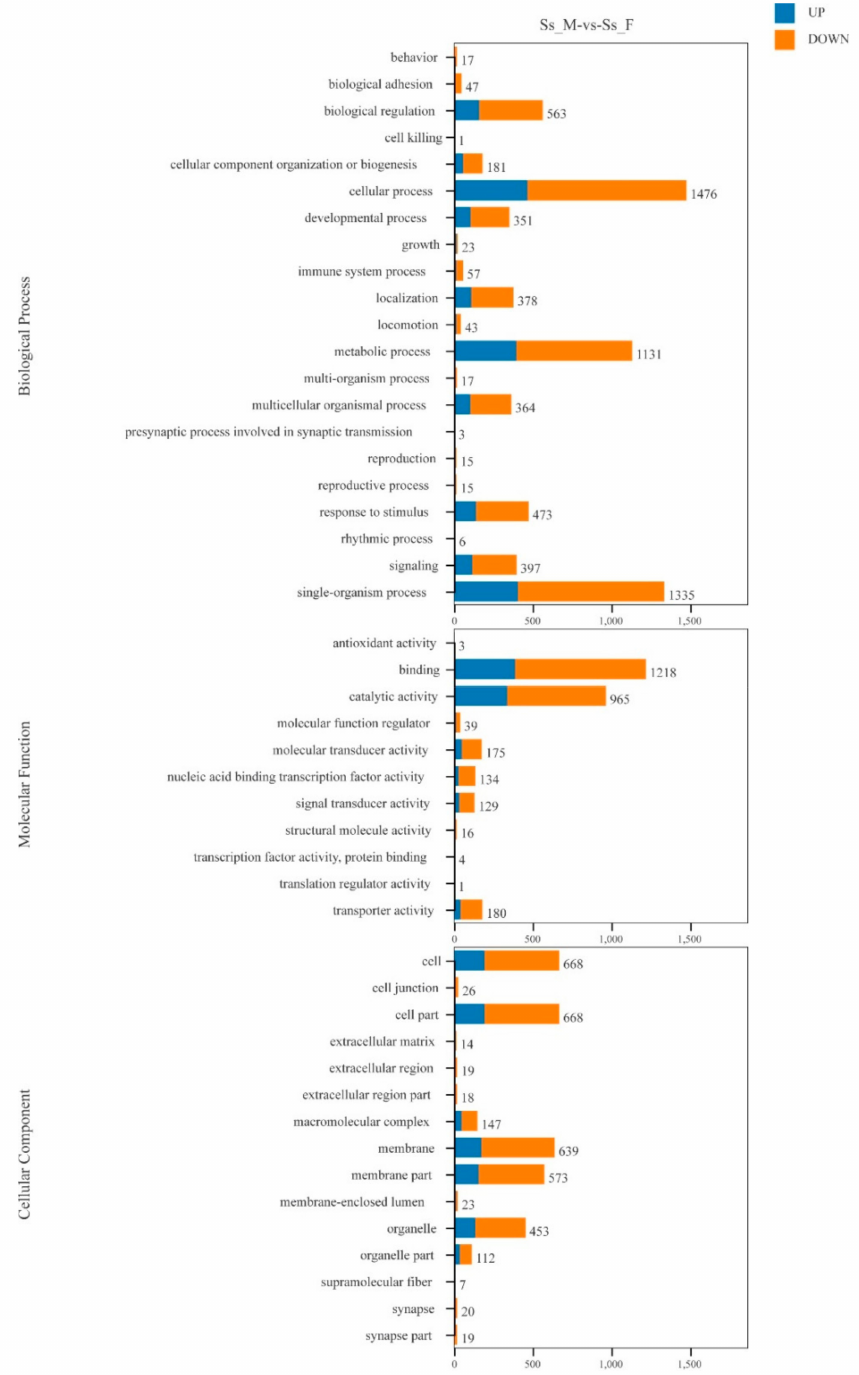
Figure 5. Distribution of differentially expressed genes (DEGs) among GO terms in biological process, cellular component, and molecular